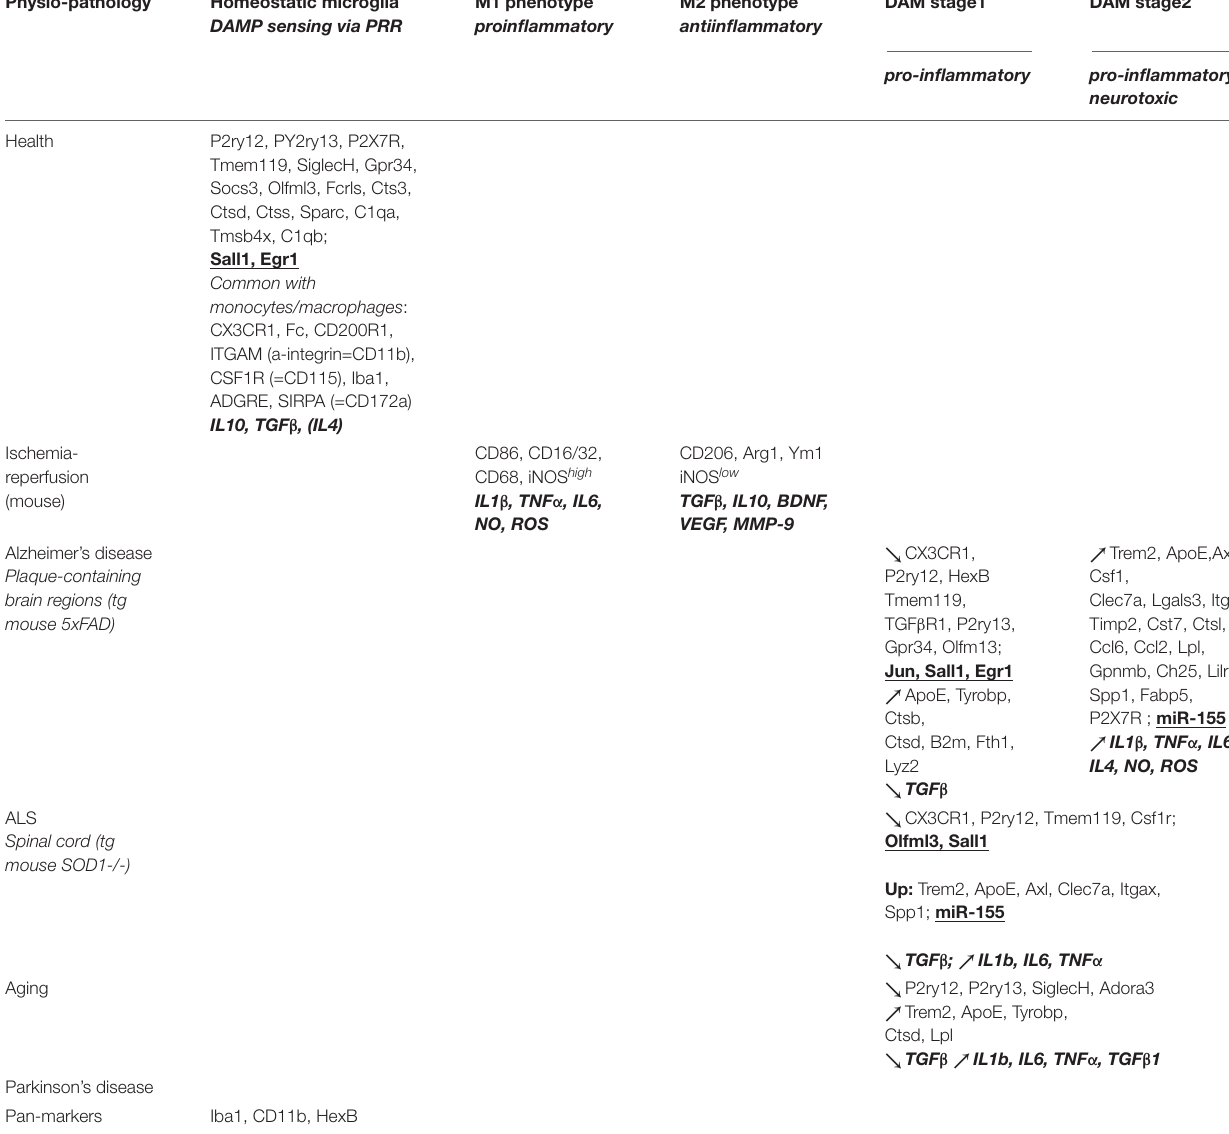
TABLE 1 | Microglia phenotypes in health and disease.